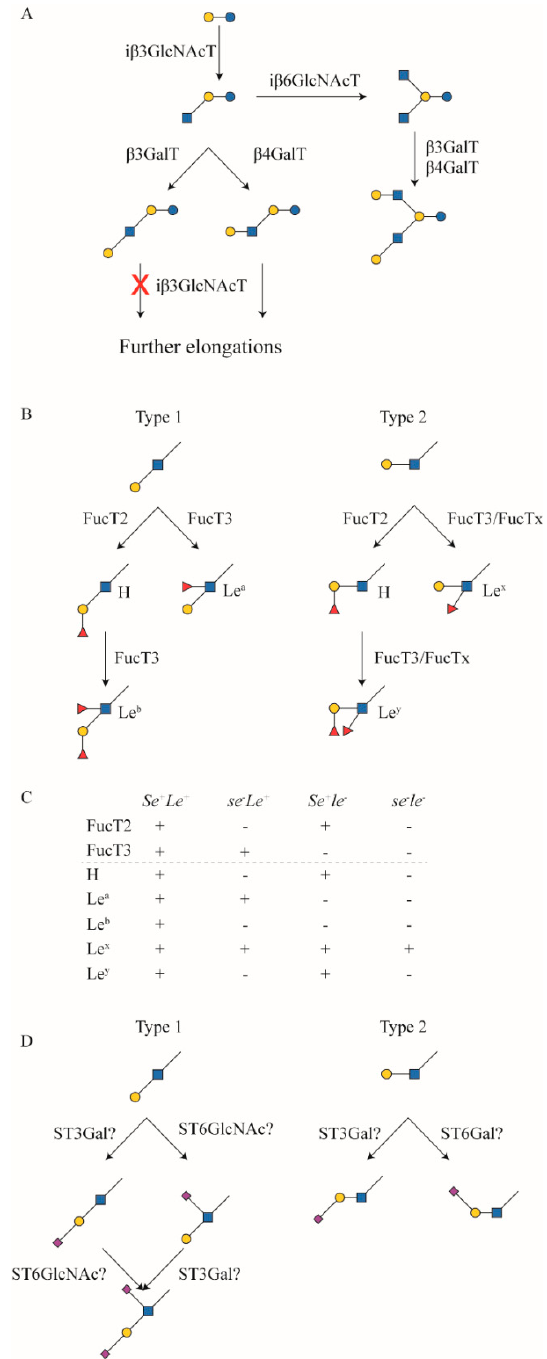
Figure 2. ( A ) Proposed biosynthesis pathways of main core structures adapted from [21] ( B ) biosynthetic pathways of fucosylated epitopes mediated by FucT2 and FucT3; and ( C ) overview of H-antigen and Lewis epitopes present in milk of Secretor ( Se + ), non-Secretor ( se − ), Lewis positive ( Le + ) and negative ( le − ) individuals; ( D ) proposed biosynthesis of sialylated structures. (cid:48) There are also studies reporting significant levels of 2 -FL and LNFP I present in milk from non-Secretor